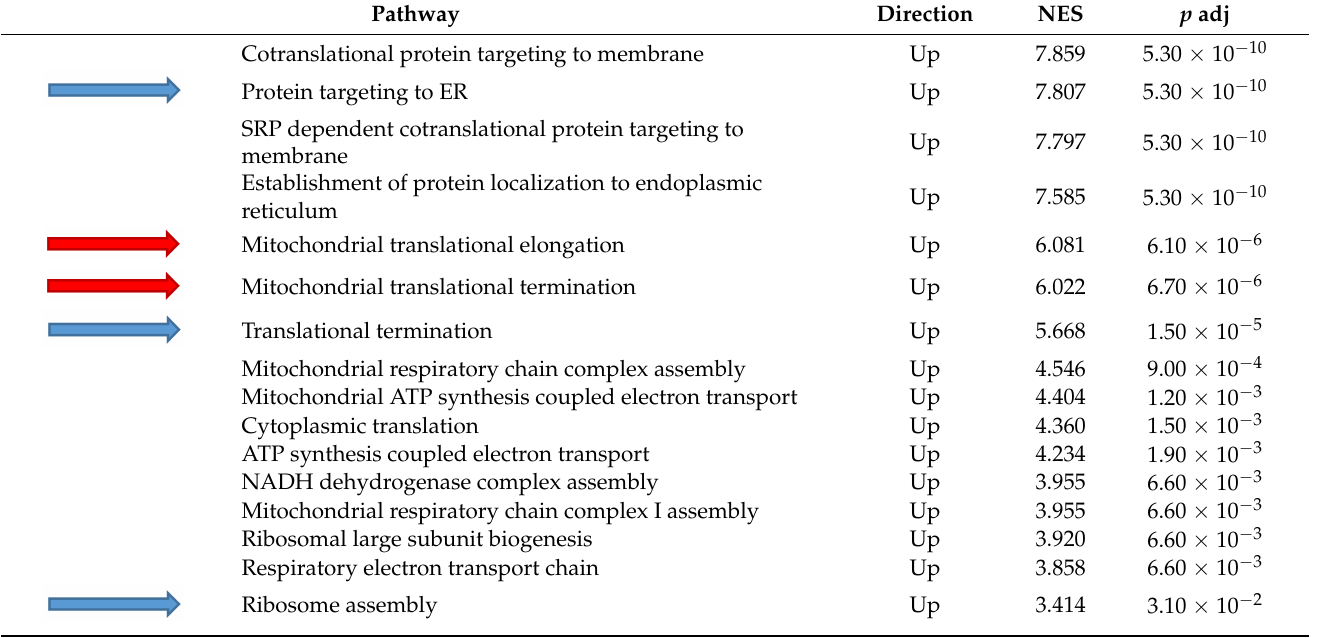
Table 1. Major signaling pathways upregulated in HEI-193 cells following chronic EMF exposure. Pathway Direction NES p adj Cotranslational protein targeting to membrane Up Protein targeting to